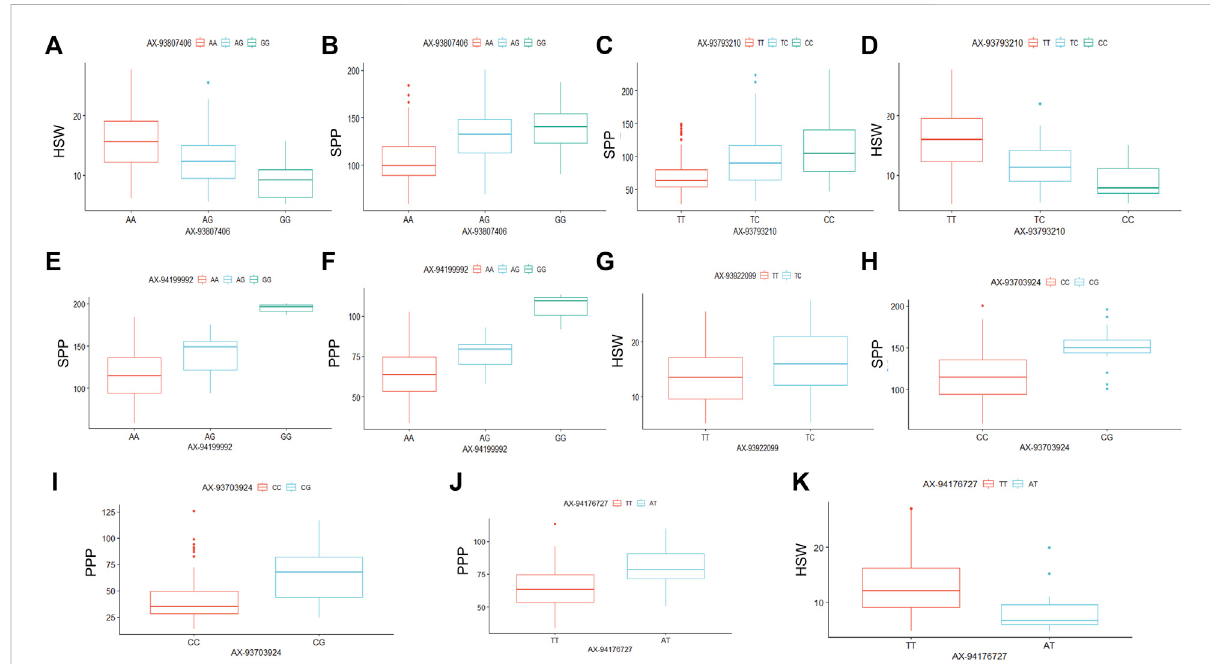
FIGURE 4 Allele-effect analysis for six stable signi fi cant SNPs including AX-93807,406 (A,B) , AX-93793,210 (C,D) , AX-94199992 (E,F) , AX-93922099 (G) , AX-93703,924 (H,I) , and AX-94176727 (G,K) . The box plot depicts the number of the alleles for each of the six signi fi cant SNPs in 211 soybean genotypes, and the contribution of these alleles to the phenotypic variation observed for yield and yield-related